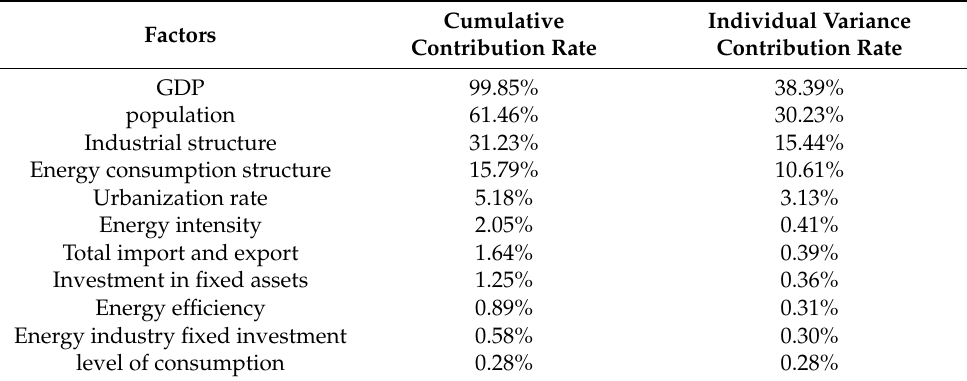
Table 3. The contribution rates of affecting